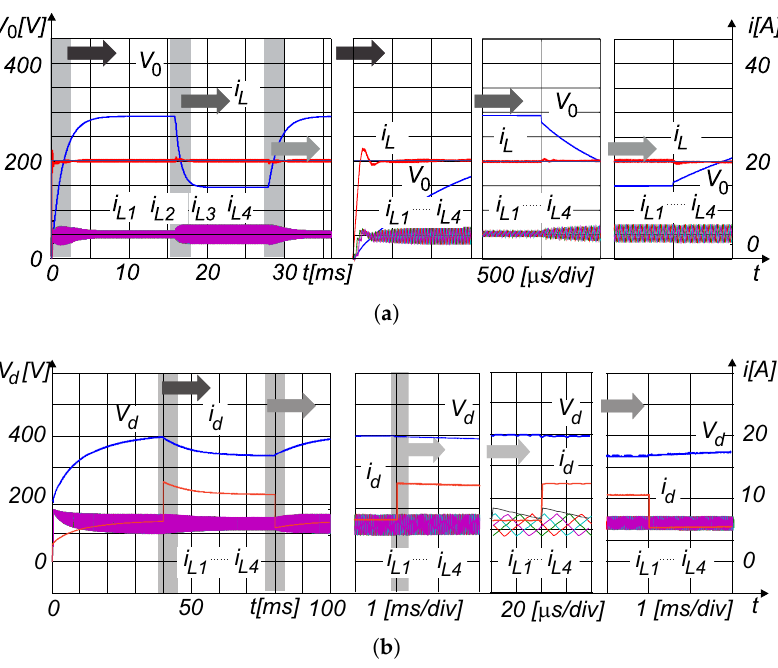
Figure 15. Simulation results, current control with PI compensator, with CR: ( a ) buck mode; ( b ) boost mode; voltage V 0 or V d (blue curve), current i L or i d (red curve), i L 1 (green curve), i L 2 (violet curve), i L 3 (cyan curve), and i L 4 (dark red curve).